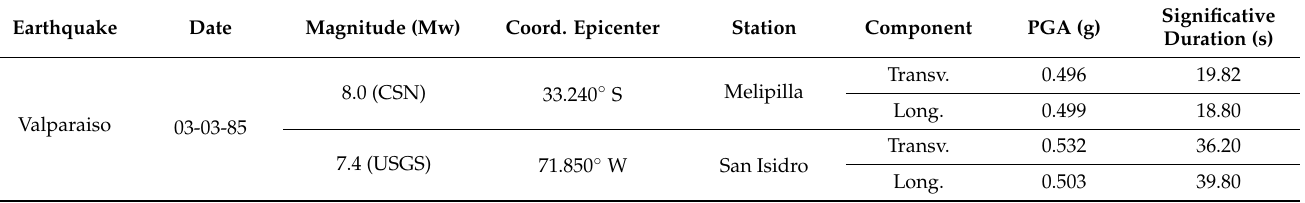
Table 1. Characteristics of the acceleration records chosen for the analyses.